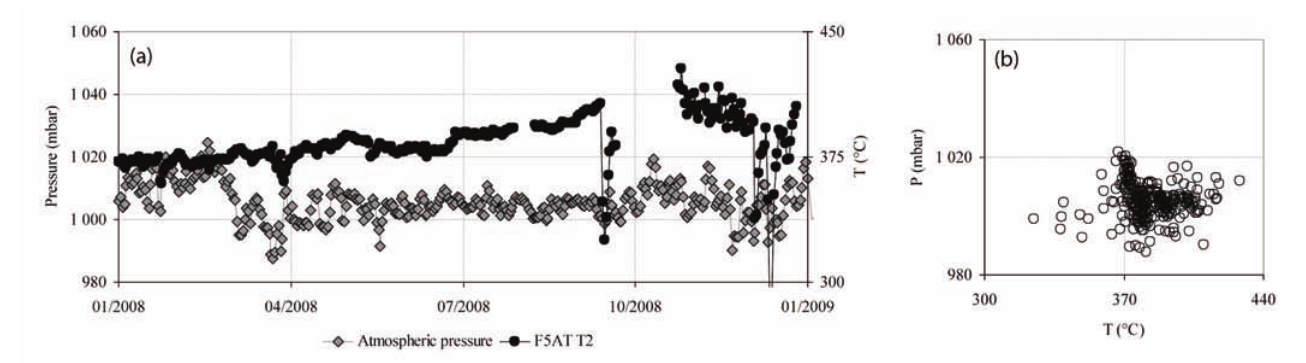
Figure 5. (a) Variations in the atmospheric pressure and the fumarole temperatures recorded over one year (2008). (b) Fumarole temperatures versus atmospheric pressures, using the data from (a).